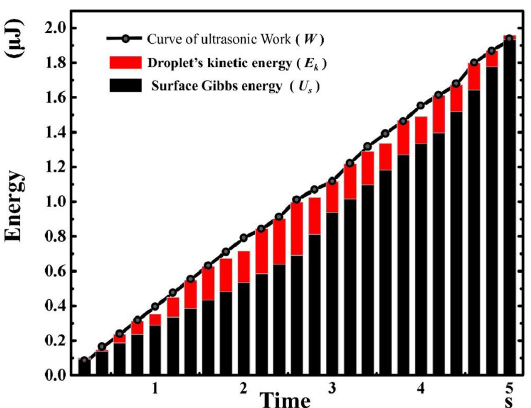
Figure 10. A fitting chart for the calculated items, surface energy U and kinetic E of Al droplet are depicted by black, red columns, surface k along with the W - t variation described by the